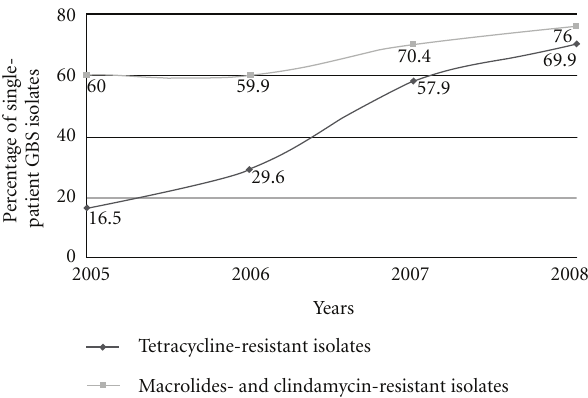
Figure 1: Annual increment (%) of resistant isolates during the study